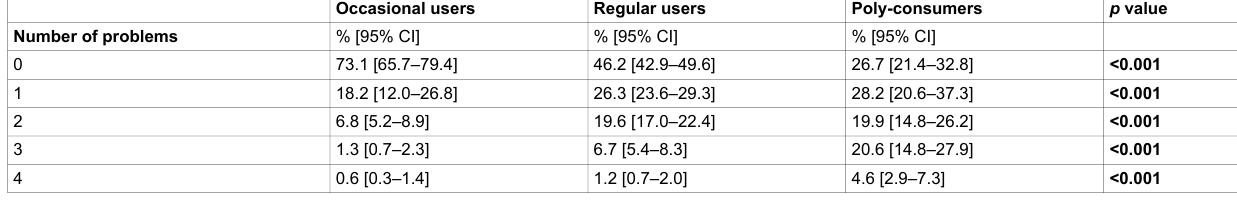
Table 3: Bivariate analysis of the number of substance-related problems according to IPS consumption profile.